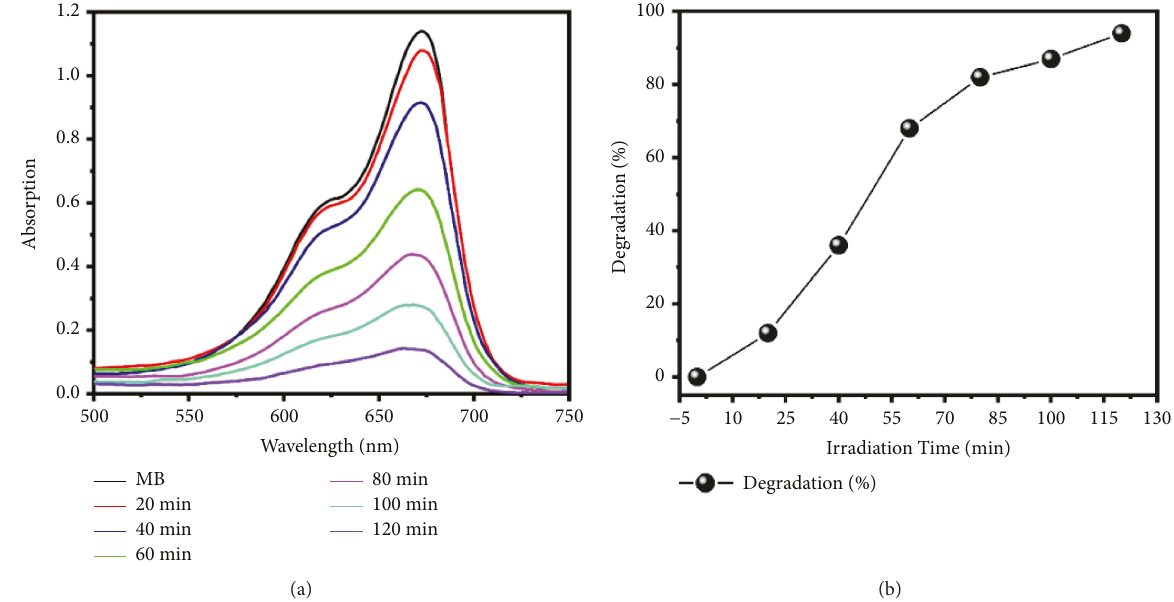
Figure 8: (a) Absorption spectrum of photodegraded MB by Cu-doped ZnO and (b) % degradation of methylene blue at various time